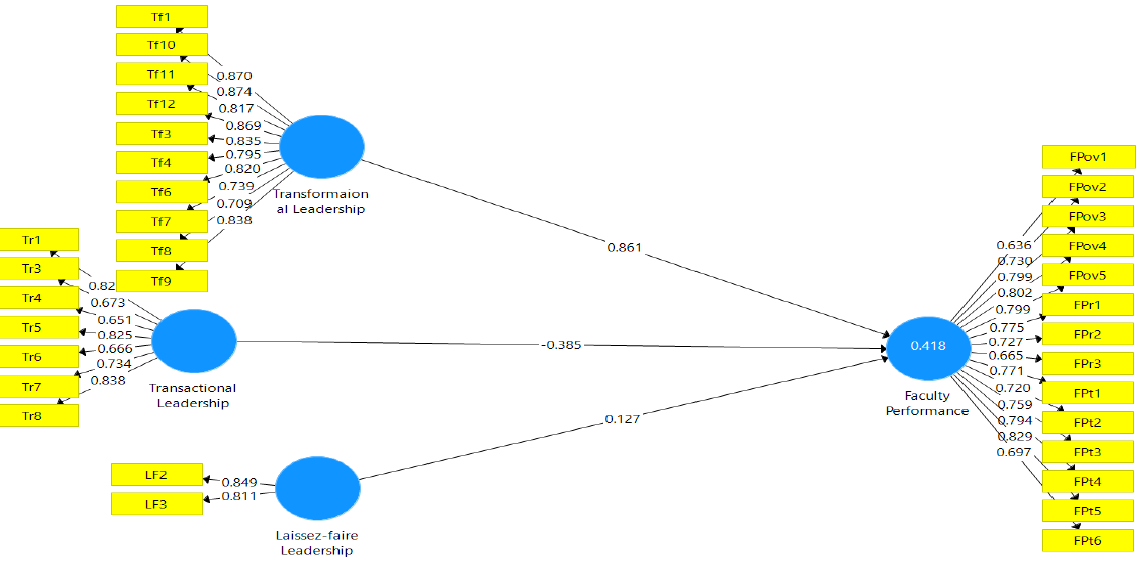
Fig 4. PLS-SEM Algorithm Results of Standardized